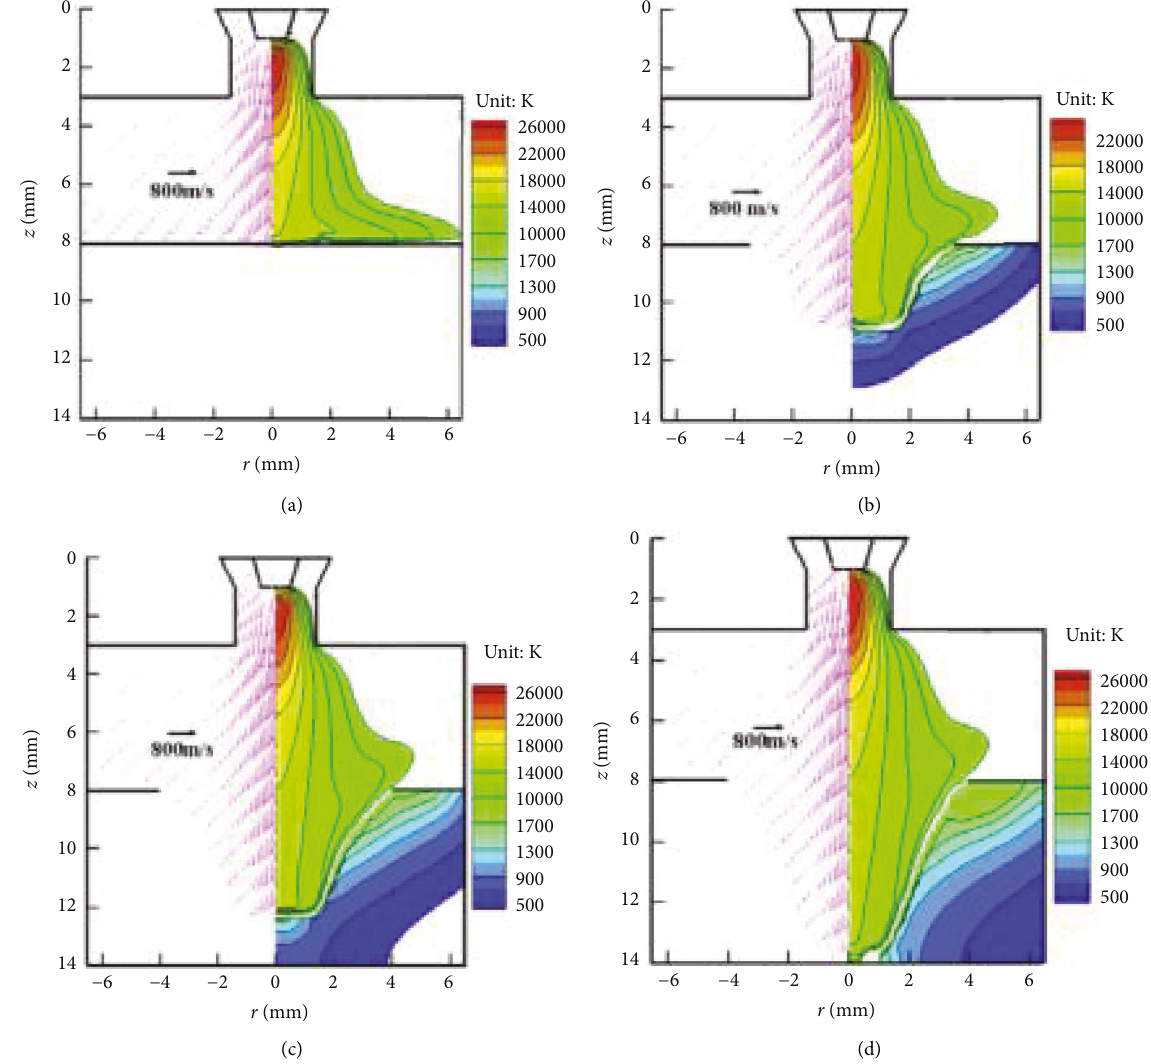
Figure 17: Evolution process of plasma arc-weld pool-keyhole at different times. (a) t � 0.001 (s), (b) t � 0.5, (s) (c) t � 1.0 s, and (d) t �